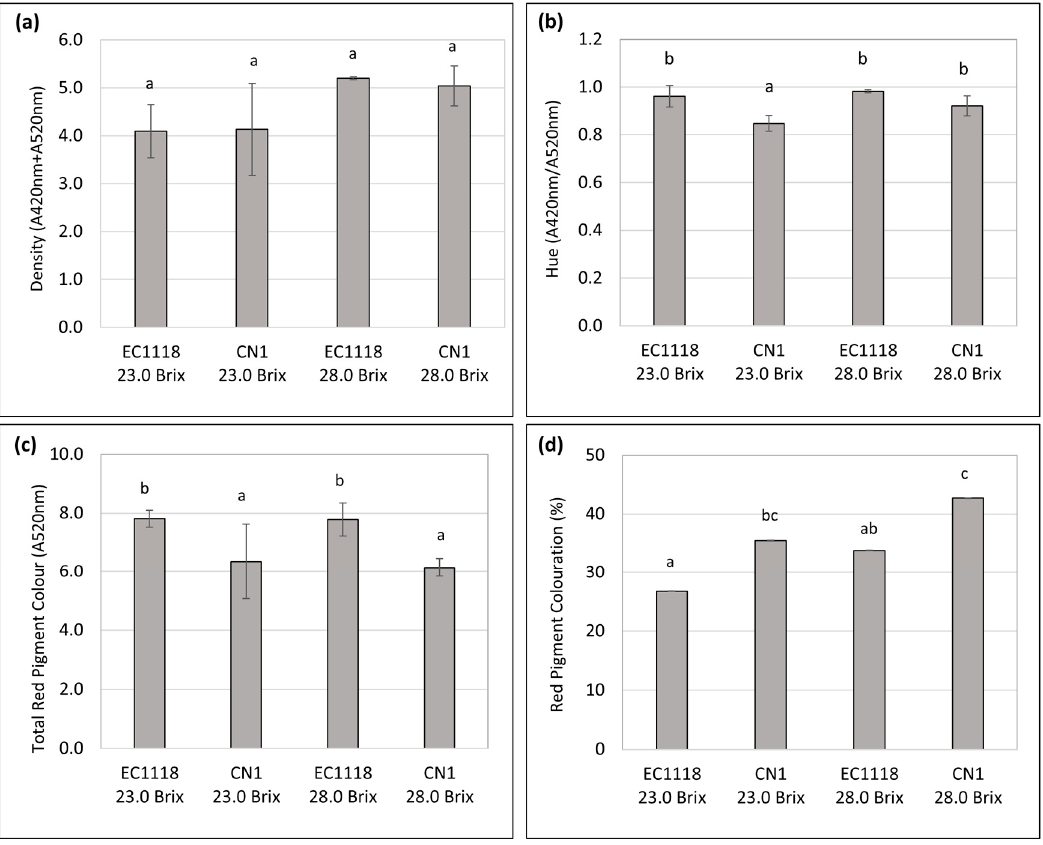
Figure 2. ( a ) Wine color density ( b ) wine hue, ( c ) total red pigment color (anthocyanins, oligomers, and polymers) and ( d ) degree of red pigment coloration (%) of control wines (23 ◦ Brix) and wines made from partially dehydrated grapes (28 ◦ Brix) vinified with either EC1118 or CN1. Data represents the mean value ± standard deviation of duplicate measurements per sample (three winemaking replicates per treatment). Lowercase letters indicate differences between treatments (Fisher’s Protected LSD 0.05